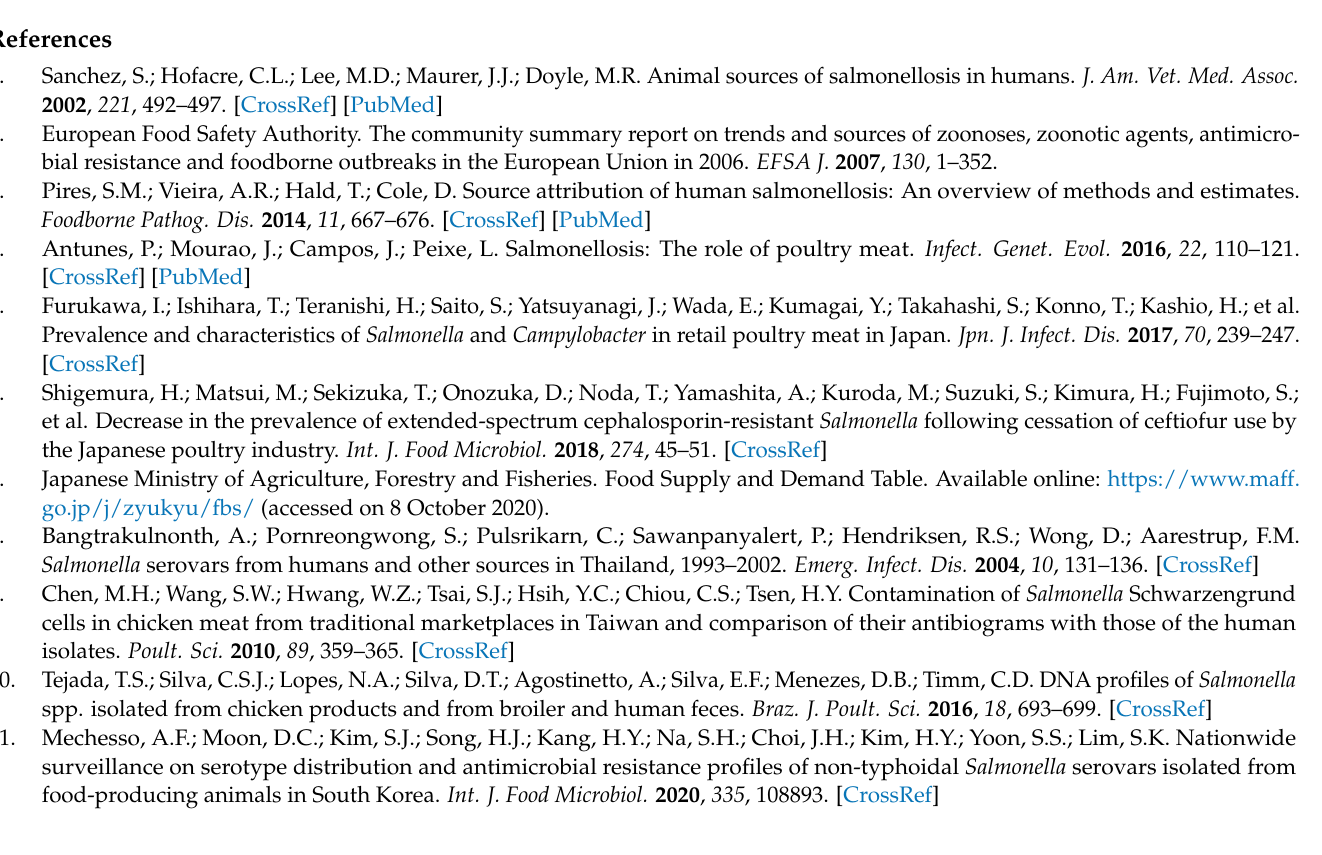
Table S3: Sequence types of Salmonella enterica serovar Schwarzengrund obtained by multilocus sequence typing analysis and their geographical distribution, Table S4: Number of bases different among the seven genes from ST96, Table S5: Salmonella enterica serovar Schwarzengrund isolates obtained from chicken meat from various production regions, Table S6: PCR conditions for detection of antimicrobial resistance genes and class 1 integron, Table S7: PCR primers used in the amplification and DNA sequencing for multilocus sequence